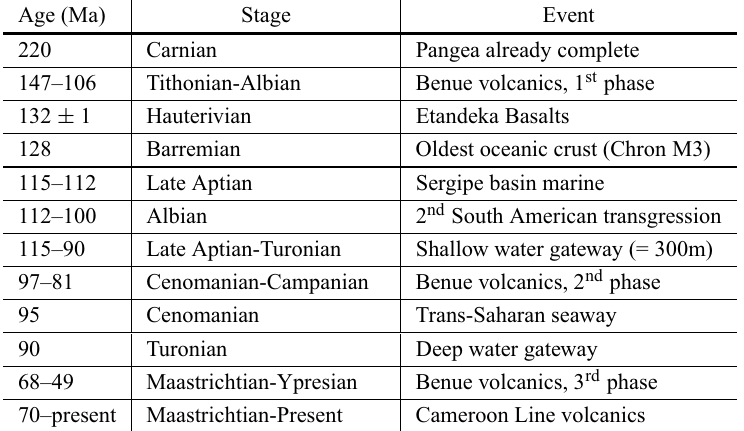
Chronological Sequence of Events in the Opening of the Equatorial Atlantic